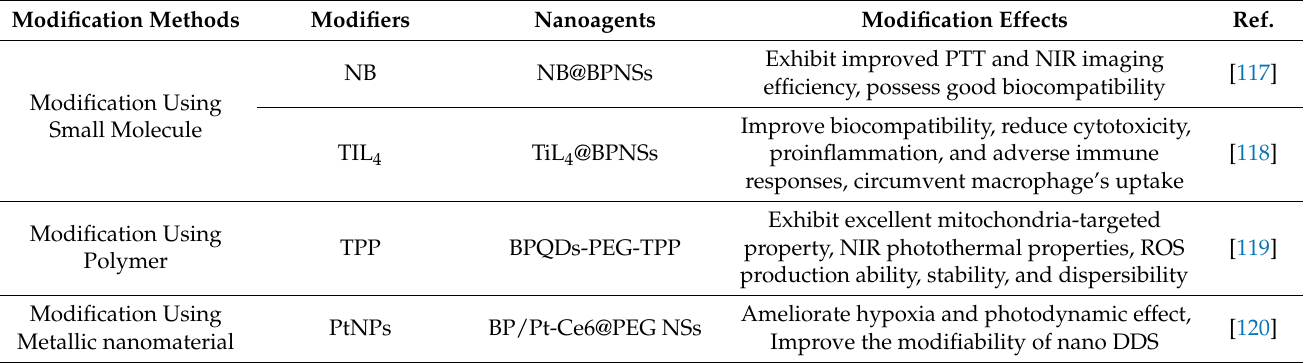
Table 3. Examples of various chemical modification methods of BP